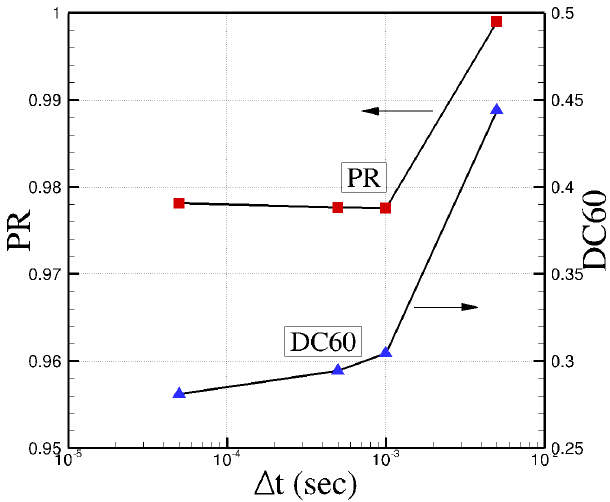
Figure 5. Time step sensitivity study. All cases were run for 2.25 s. Predictions between time 2 to 2.25 s were time-averaged. NASA baseline grid with SARC–DDES turbulence model was